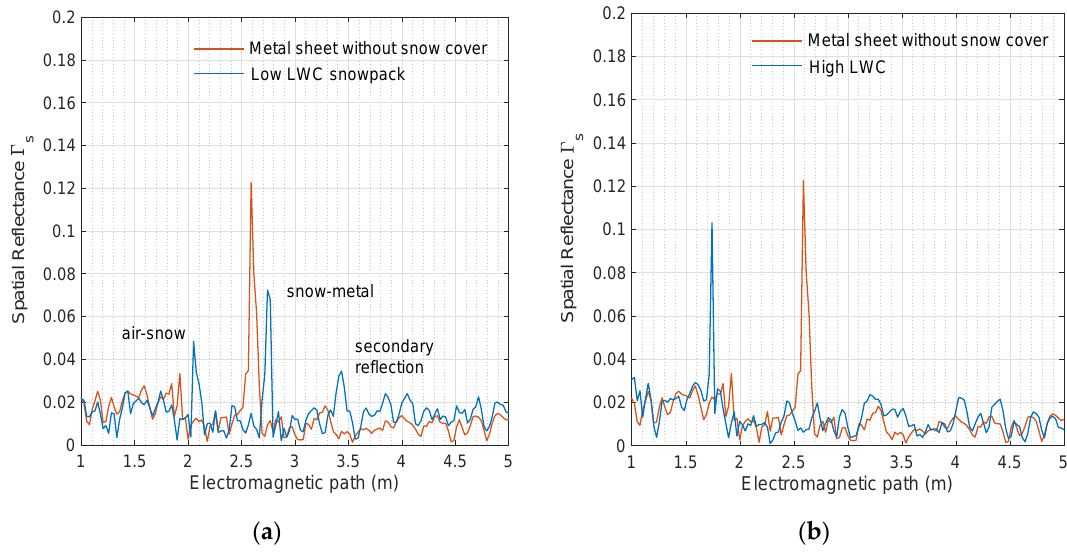
Figure 15. Spatial reflectances of two measurements compared with the metal sheet without snow cover case (orange): ( a )